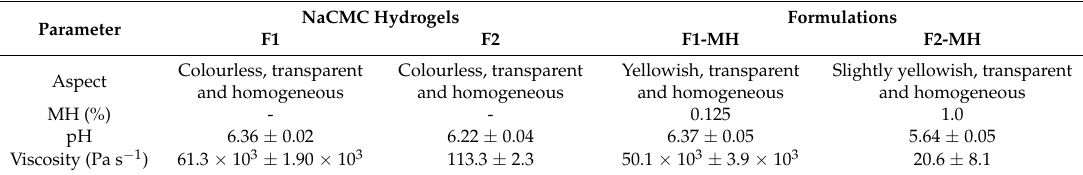
Table 3. Main characteristics of the NaCMC semi-solid (F1-MH) and fluid (F2-MH) morphine- containing hydrogels (mean ± SD, n = 3).